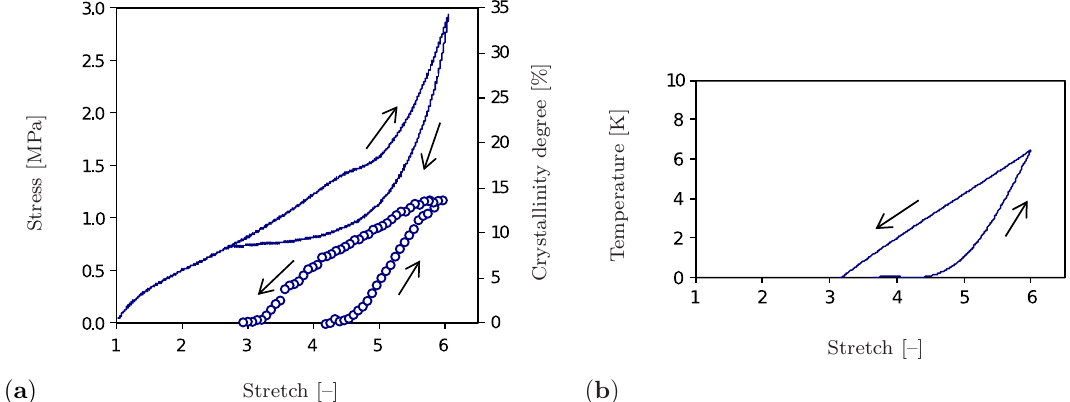
Figure 1. Uniaxial cyclic tensile test for a vulcanized unfilled natural rubber at room temperature and at a constant strain rate of 4.2 10 − 3 s − 1 [12]. ( a ) Stress–stretch diagram (solid line) and crystallinity × degree–stretch diagram (circle symbols). ( b ) Temperature–stretch